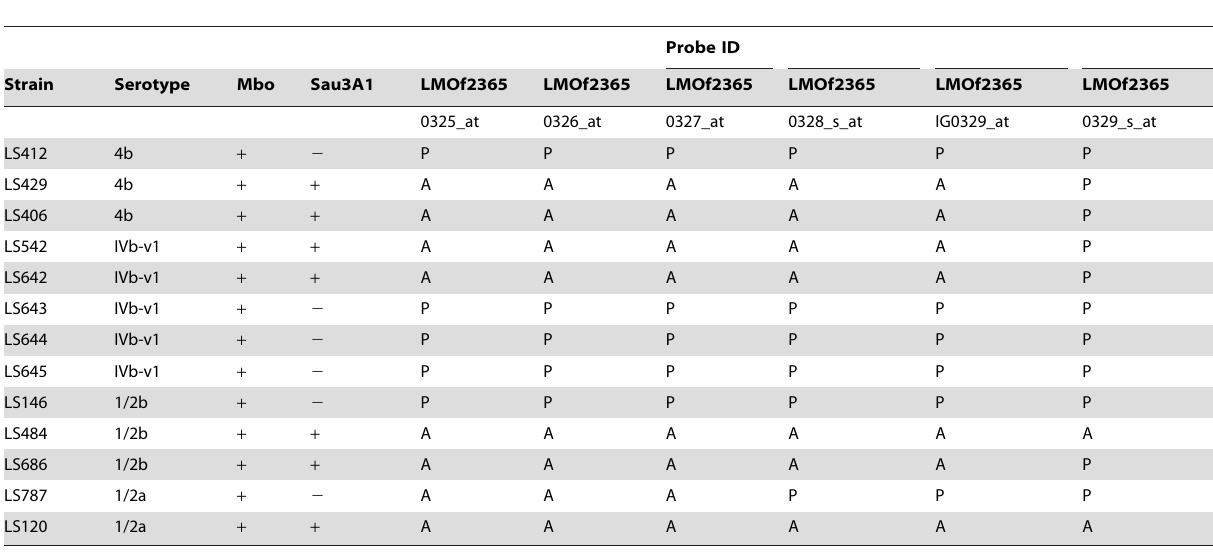
Table 5. Susceptibility to Mbo1 and Sau3A digestion and distribution of the genes in the restriction-modification cassette in selected L. monocytogenes